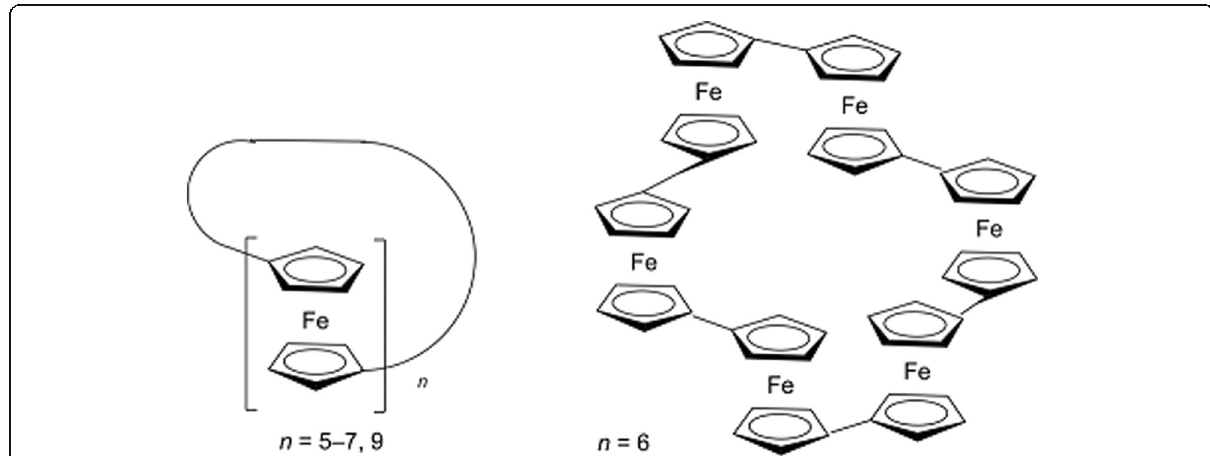
Fig. 1 Cyclic hexaferrocene (four single-electron transfer CV waves are observed, the two others being out of scale) and other cyclic poly(ferrocenes), Fc n